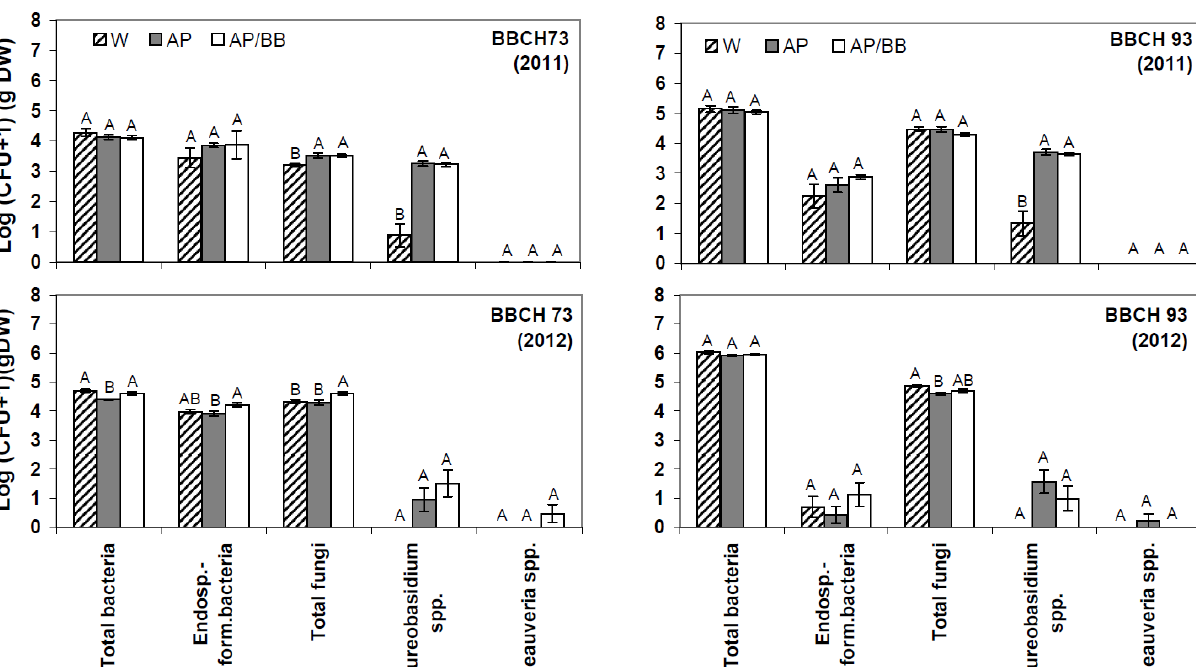
Figure 2. Culturable phyllosphere microbiota in strawberries at two distinct phenological stages (BBCH 73 and BBCH 93) during two subsequent years (2011, 2012) as determined by plate counts ( N = 12). Aureobasidium pullulans was introduced as a model organism either as a single strain treatment (AP) or co-inoculated with Beauveria bassiana (AP/BB) through commercial formulations. The two phenological stages represent short- (BBCH 73, after four BCA applications) and long-term effects (BBCH 93, four weeks after adjournment of BCA applications). The control (W) was treated with water from a lotic reservoir. Error bars represent SEM values. Columns marked with the same letters are not significantly different within each microbial group ( α =